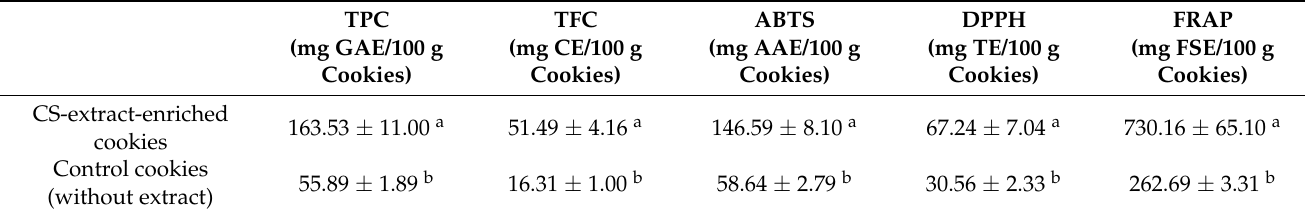
Table 3. Total phenolic and flavonoid contents and antioxidant/antiradical activity of functional cookies enriched with chestnut shells extract and control cookies (without